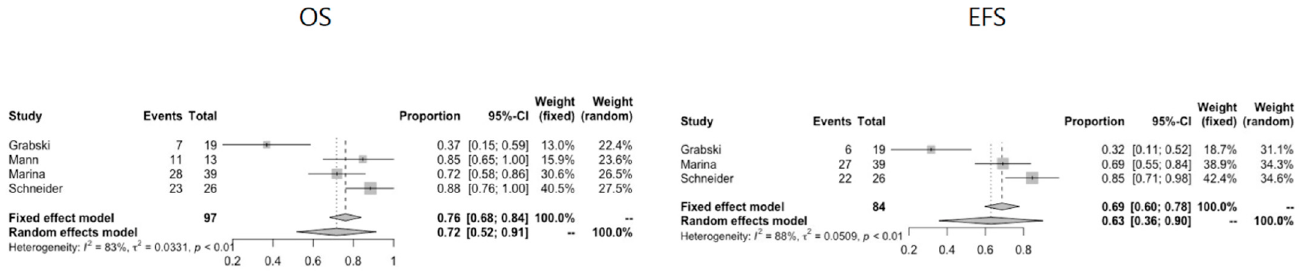
Figure 5. Pooled OS and EFS data for mediastinal GCTs.